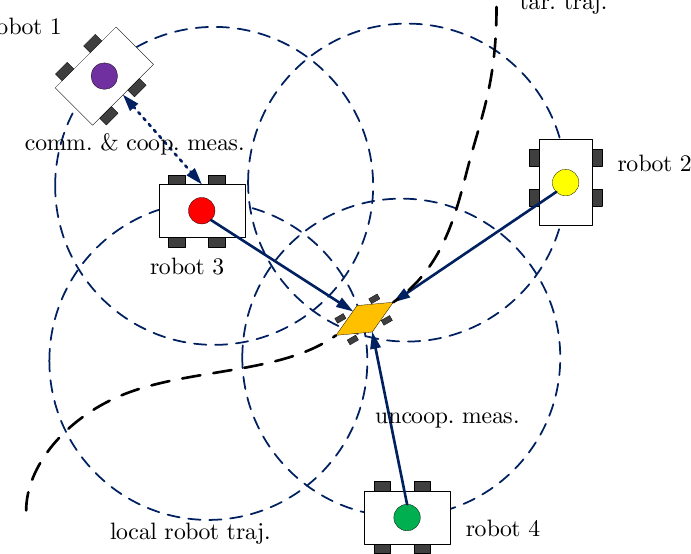
Figure 1. Simulation with four local robots and one moving